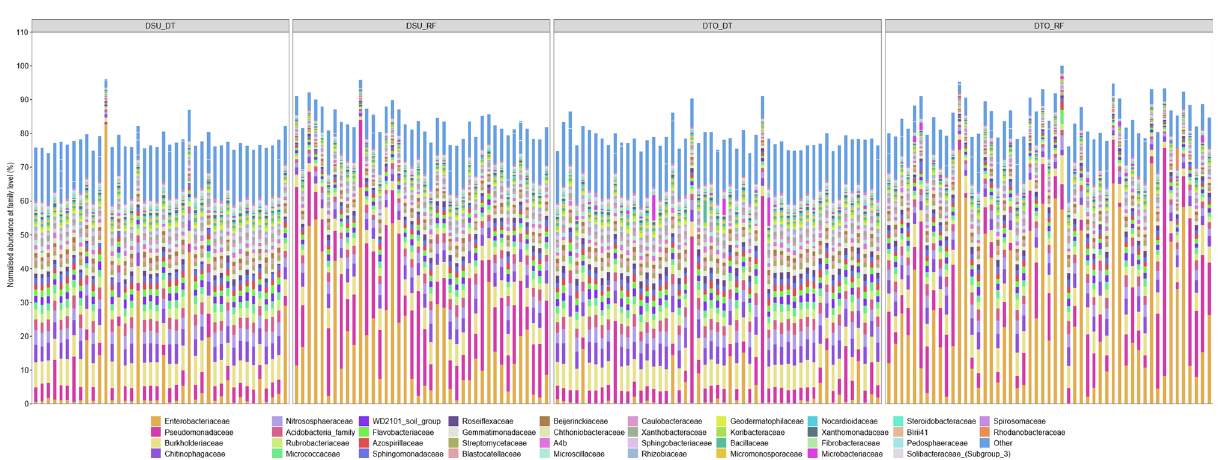
Figure 3. Comparison of the microbiomes (normalised percent abundance) of wheat plants under drought and rainfed conditions (DSU-DT—drought susceptible lines under drought conditions, DTO—DT drought tolerant lines under drought conditions, DSU-RF—drought susceptible under rainfed conditions and DTO-RF— drought tolerant under rainfed conditions) at the family level. Each column represents a microbial profile of a wheat line replicate under the above-mentioned specified